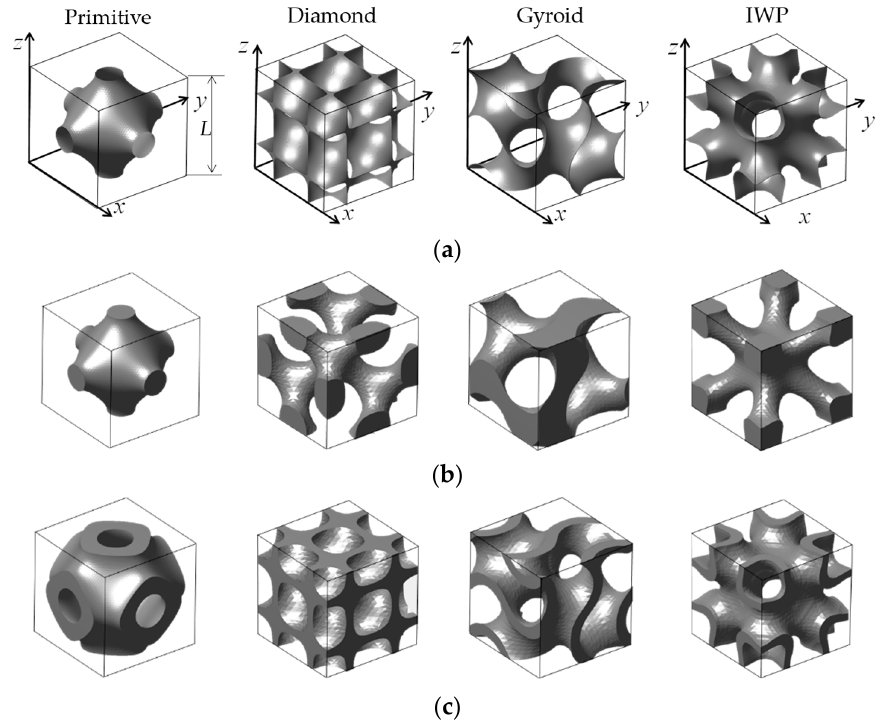
Figure 3. Unit cell examples of typical TPMS structures at the same porosity (The TPMS structures are generated using MSLattice software [22]): ( a ) Minimal surfaces; ( b ) Solid-TPMS structures; ( c ) Sheet-TPMS structures.